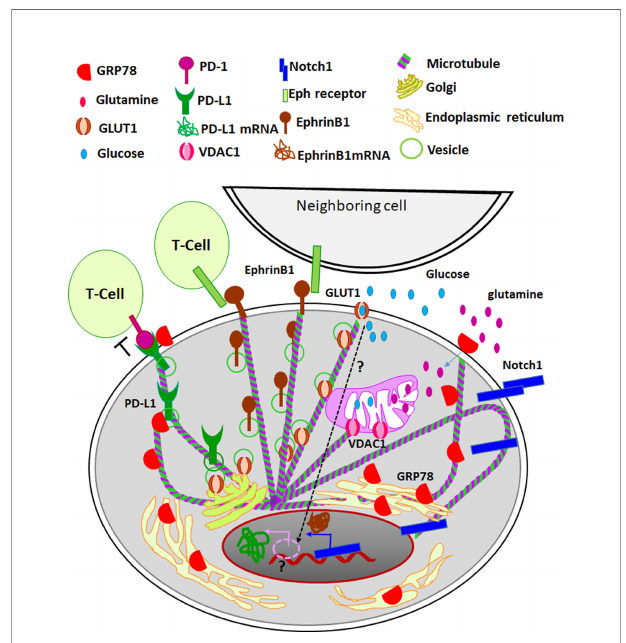
FIGURE 3 | The role of tubulins in CSC niche. Different tubulin isotypes regulate metabolic reprogramming important for the induction of CSCs. While hypoxia is a critical factor that activates the expression of GLUT1-the regulator of aerobic glycolysis and metabolic reprogramming, its surface localization is controlled by b IVb tubulin. Also, other isotypes of tubulin, b II and b III, regulate the opening and closing of VDACs, which also is a crucial regulation of metabolic reprogramming. The endoplasmic reticulum residing GRP78 is shown to surface localize during cellular stress, the transport of the molecules is thought to be modulated by b III tubulin. The surface localized GRP78 enhances glutamine intake and its metabolism, which also contributes to the metabolic reprogramming. In parallel, certain master regulators of self-renewal, like Notch1 leads to transcriptomic regulation for the induction of stemness. The nuclear transport of the active cleaved Notch1 is facilitated by b II tubulin. EphrinB1, a target gene of Notch 1, leads to Eph/Ephrin bidirectional signaling. The surface transport of EphrinB1 is shown to be dependent on b IVb tubulin. Eph/Ephrin signaling regulates the fate of cancer cells and immune in fi ltrates. When PD1 on T-cells is engaged by its ligand PD-L1, it leads to the inhibition of T-cell activity. The aberrant expression of PD-L1 on cancer cells leads to immune evasion. While the expression of PD-L1 is indirectly regulated by GLUT1 activity through unknown mechanism (shown as dotted arrow and question mark), stabilization of its surface localization is shown to be mediated by GRP78. Thus different speci fi c isotypes of tubulins are involved in the transport of critical molecules involved in metabolic reprogramming, induction of stemness and immune evasion in CSC